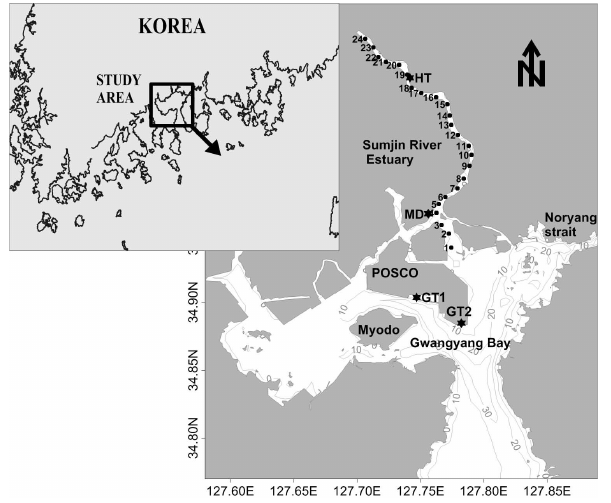
Fig. 1. Map of the study area. Solid circles indicate CTD stations. Stars denote the Gwangyang (GT1 and GT2), Mangdock (MD) and Hadong (HT) tide observation